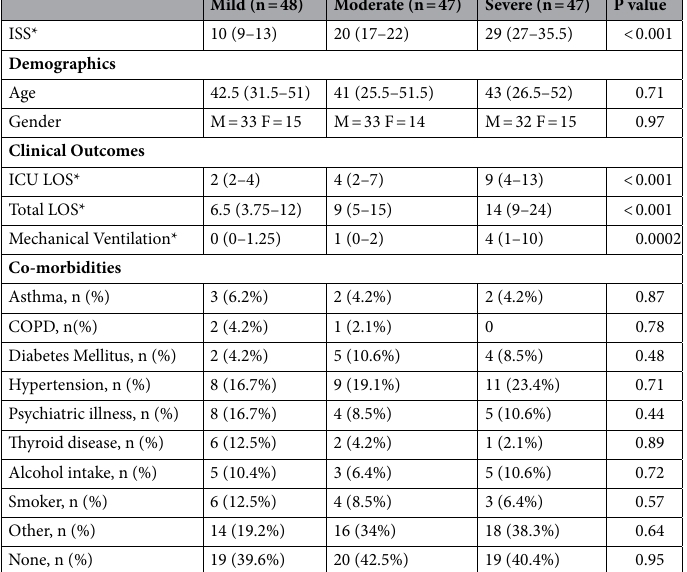
Table 1. Demographics, clinical outcomes, and co-morbidities of mild, moderate, and severely injured patients. Cohorts were age- and gender-matched. Length of stay in the ICU (ICU LOS), total length of stay (Total LOS), and days on mechanical ventilation increase with injury severity. Values are expressed as median (1st-3rd quartile range).